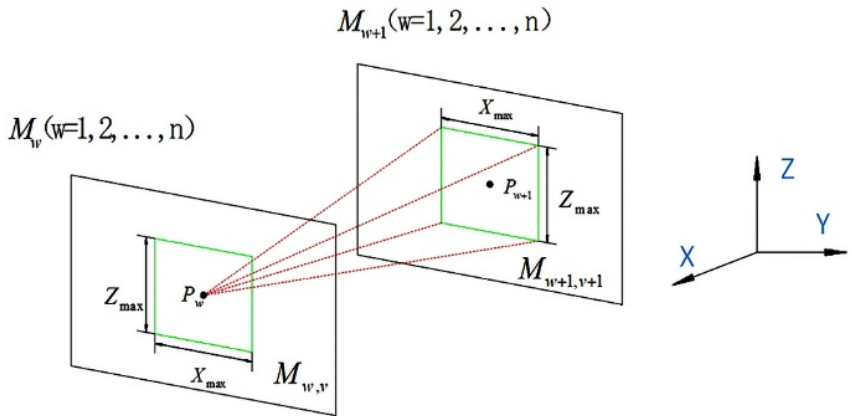
Figure 8. Limiting the effective searchable